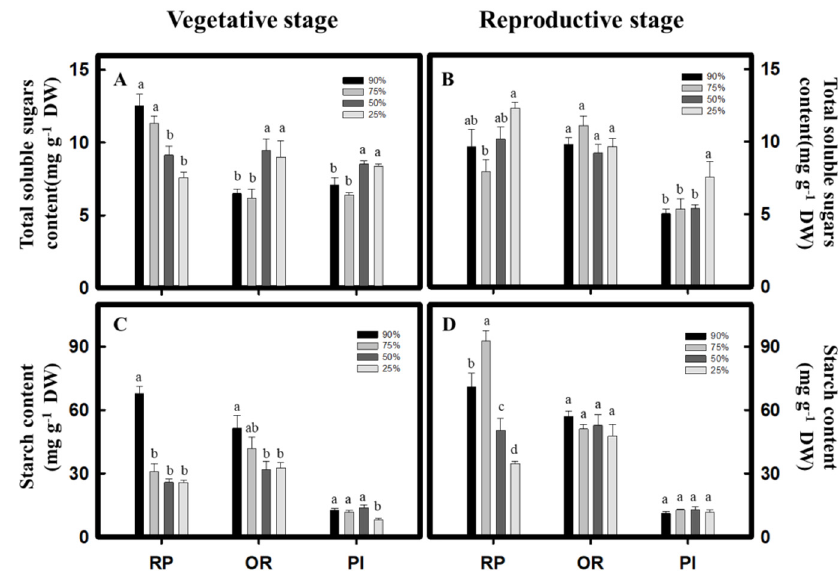
Figure 6. Effect of drought stress on total soluble sugars and starch content in C. formosana and C. quinoa . C. formosana RP variety, OR variety, and C. quinoa PI variety grow to vegetative stage and reproductive stage; the total soluble sugars ( A , B ) and starch content ( C , D ) were investigated, respectively. Bars show means ± SE. Values with the same letter are not significantly different in treatments between the same variety by LSD ( p < 0.05, n = 4).